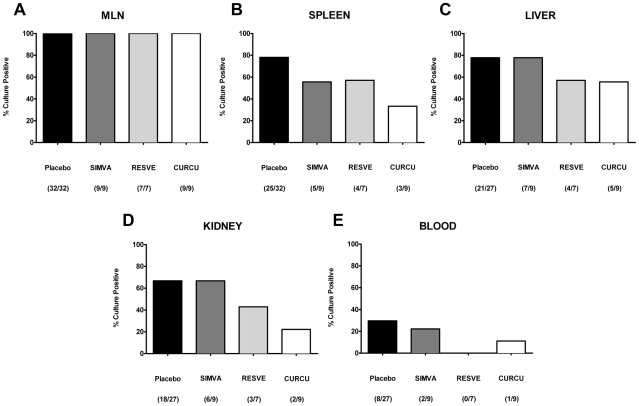
Bacterial translocation into (A) MLN, (B) Spleen, (C) Liver, (D) Kidney, and (E) Blood of mice treated with Simvastain (SIMVA), Resveratrol (RESVE) or Curcumin (CURCU) from d-2 until d8 p.i. as compared to Placebo controls (8 days after T. gondii infection).Organs or blood were cultivated in thioglycolate broth for maximum 7 days. Turbid broths were sub-cultivated on solid media (refer to Materials). Indicated are relative rates of positive samples (in %) and absolute numbers of positive samples out of total number analyzed in parentheses.